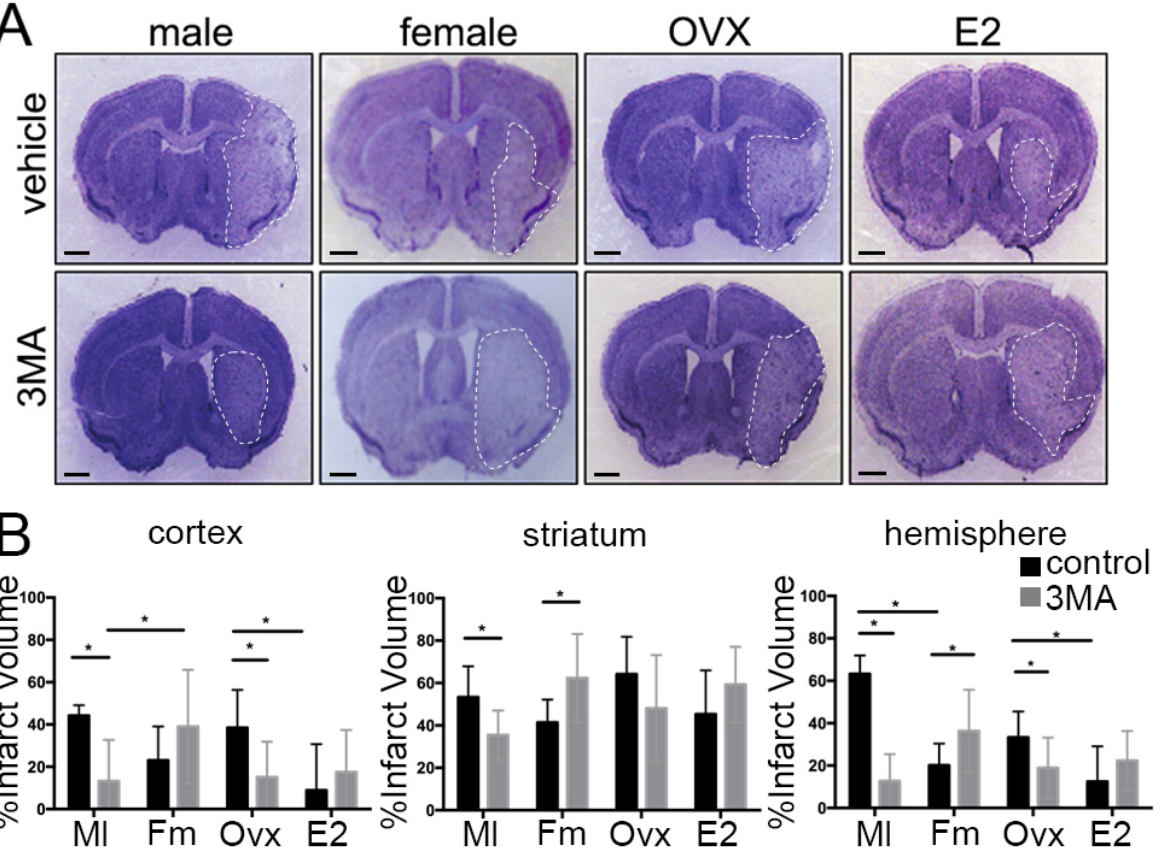
Figure 1. Infarct size following 3MA treatment. ( A ) Representative cresyl violet staining of 3MA and vehicle-treated male, female, OVX and E2 supplemented stroke mice 72 h after stroke onset. Scale bar, 1 mm. ( B ) Quantification of infarct volume in cortex, striatum, and hemisphere. * Represents statistical significance ( p < 0.05).